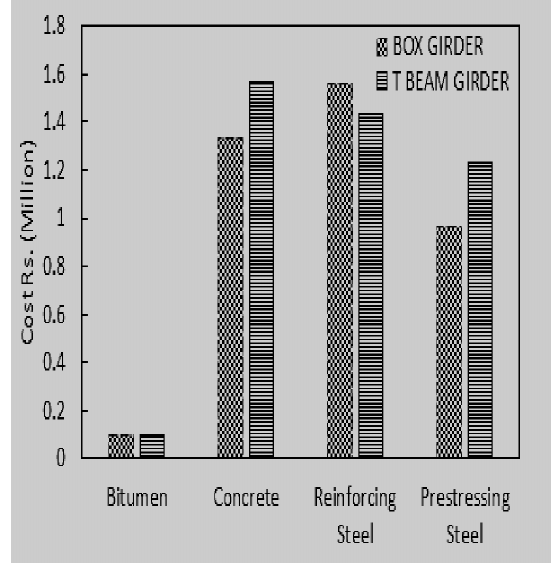
FIG. 11: COST COMPARISON BETWEEN BOX AND T BEAMGIRDER BRIDGE IN MILLIONS Box girder is expensive w.r.t to reinforcing steel by amount of 0.12 million represented by Fig. 11. T